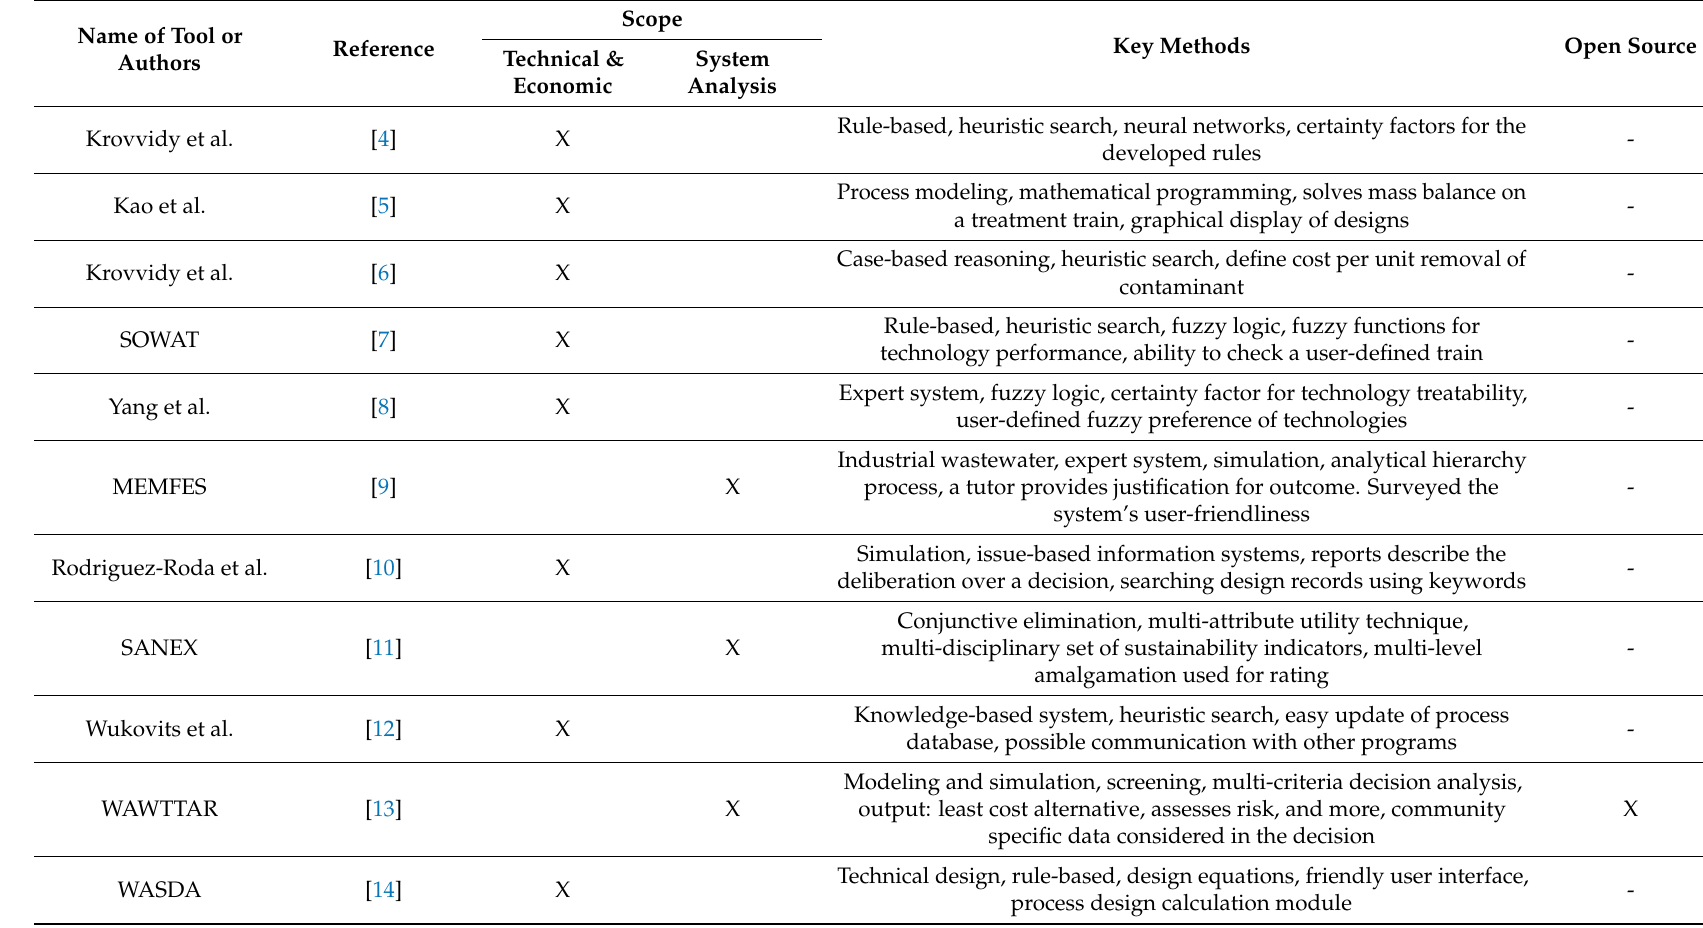
Table 1. Selected list of main decision support systems reported in literature